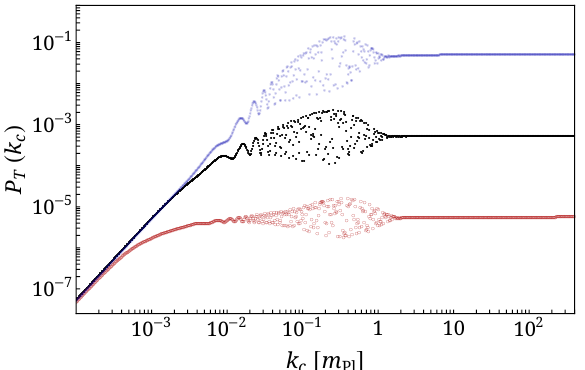
Figure 14. Primordial tensor power spectra obtained from an evolution with a bounce characterized by C = 1, µ = − 400, σ = 2, and B = 0.4, and three different values of the Hubble parameter during inflation. From top to bottom: H 0 = 0.1 (blue stars), H 0 = 0.01 (reference case, black disks), and H 0 = 0.001 (red